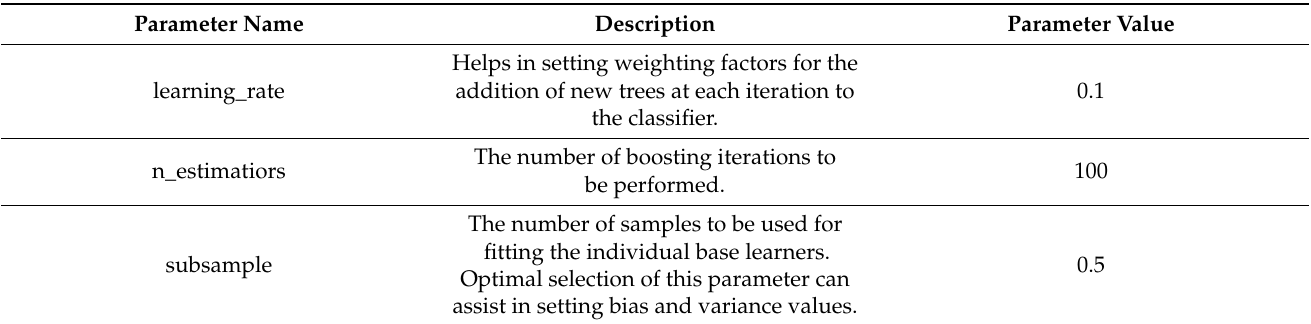
Table 2. The hyperparameter’s values for the NGBoost algorithm used in the proposed method.